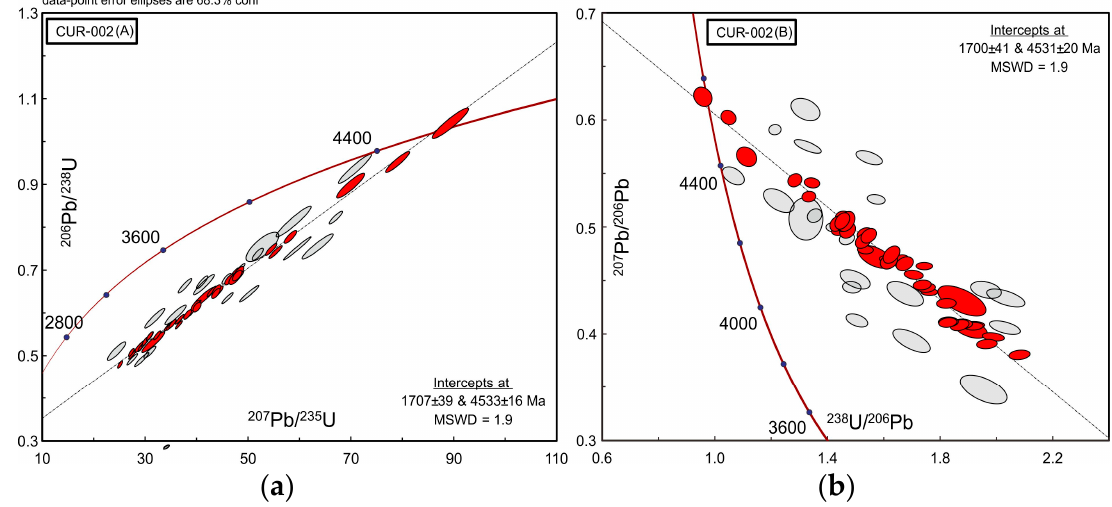
Figure 6. Conventional concordia plot ( a ) and Tera ‑ Wasserburg diagram ( b ) for the low ‑ U sample (CUR ‑ 002; Carajás, Brazil). The more robust data points marked in red are included in the age regression. Data given in Table 5 as “included” are plotted in red, “excluded” as grey.